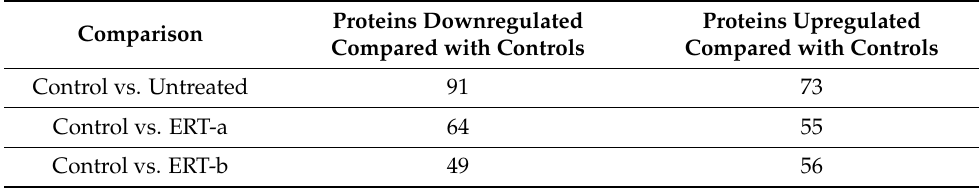
Table 3. Dysregulated proteins in leukocyte samples from MPSIVA patients. Proteins considered dysregulated are those with a p -value < 0.05 and a fold change (FC) > 1.4. Proteins Downregulated Proteins Upregulated Comparison Compared with Controls Compared with Controls Control vs. Untreated 91 73 Control vs. ERT-a 64 55 Control vs. ERT-b 49 56 Proteins down regulated com- Proteins upregulated compared Comparison pared with untreated group with untreated group Untreated vs. ERT-a 22 10 Untreated vs. ERT-b 10 23